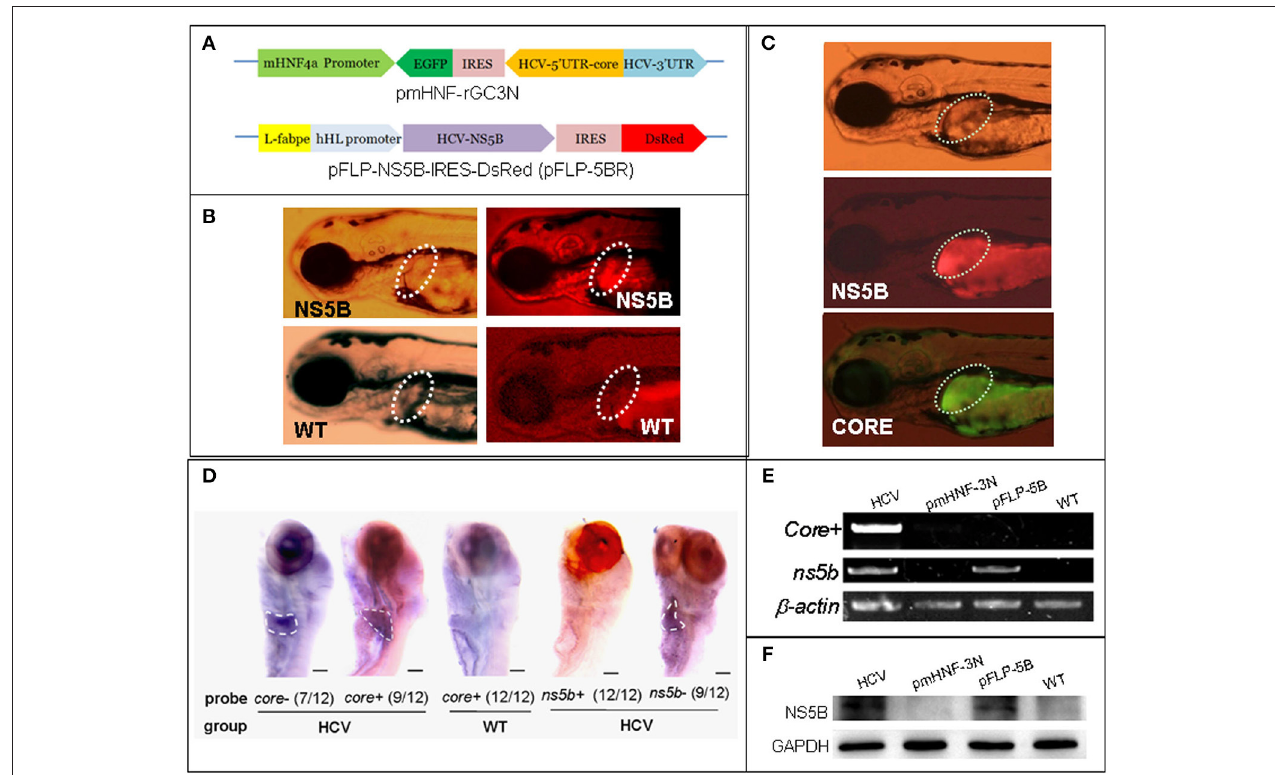
FIGURE 1 | A zebrafish model of liver-specific HCV sub-replicon. (A) Cartoon representation of the structures of the two HCV sub-replicon vectors. The HCV sub-replicon was composed of both vectors pmHNF-3N and pFLP-5B. pmHNF-rGC3N was constructed with a mouse HNF4a promoter sequence and a complementary cDNA sequence of gfp-IRES(EMCV)-core-5 ′ UTR fused cDNA that was reversely inserted at the downstream of the mHNF promoter and followed by a sense HCV 3 ′ UTR sequence. Vector pFLP-5BR was consisted with zebrafish liver- fab enhancer and human HL promoter sequence as the transcription regular elements, followed by HCV RNA polymerase cDNA (NS5B), IRES2 (EMCV), and RFP cDNA. (B) NS5B expression in the livers of zebrafish larvae injected with pFLP-5BR compared to uninjected wild type fish (WT). Four-days post fertilization larvae were detected using a white light, and fluorescent RFP filter (556nm excitation, 586nm emission) under a fluorescence microscopy. (C) Fluorescence image of a live zebrafish larva at 4 days post fertilization (dpf) showing liver-targeted expression of the HCV subreplicon. Photos taken under a fluorescence microscopy using a GFP filter (480nm excitation, 505nm emission) and a RFP filter (556nm excitation, 586nm emission). Green fluorescence indicates the HCV core protein and red fluorescence indicates the HCV NS5B protein. (D) Whole mount in situ hybridization was used to detect the HCV subgenome model. The probe core - (HCV core antisense RNA) identified the sense strand of HCV core RNA, representing a relative replication level of the HCV subreplicon; the core + probe (HCV core sense RNA) identified the antisense strand of core RNA, representing a relative transcription level of the HCV subreplicon directed by the mHNF4a promoter; the ns5b + probe identified antisense strand of ns5b RNA (as a negative control);